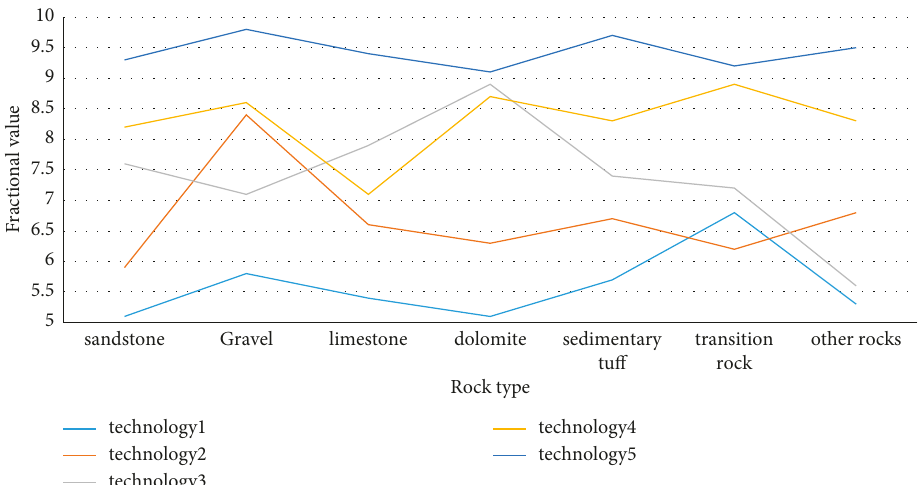
Figure 8: Exploration effects of different technologies on different reservoir characteristics.